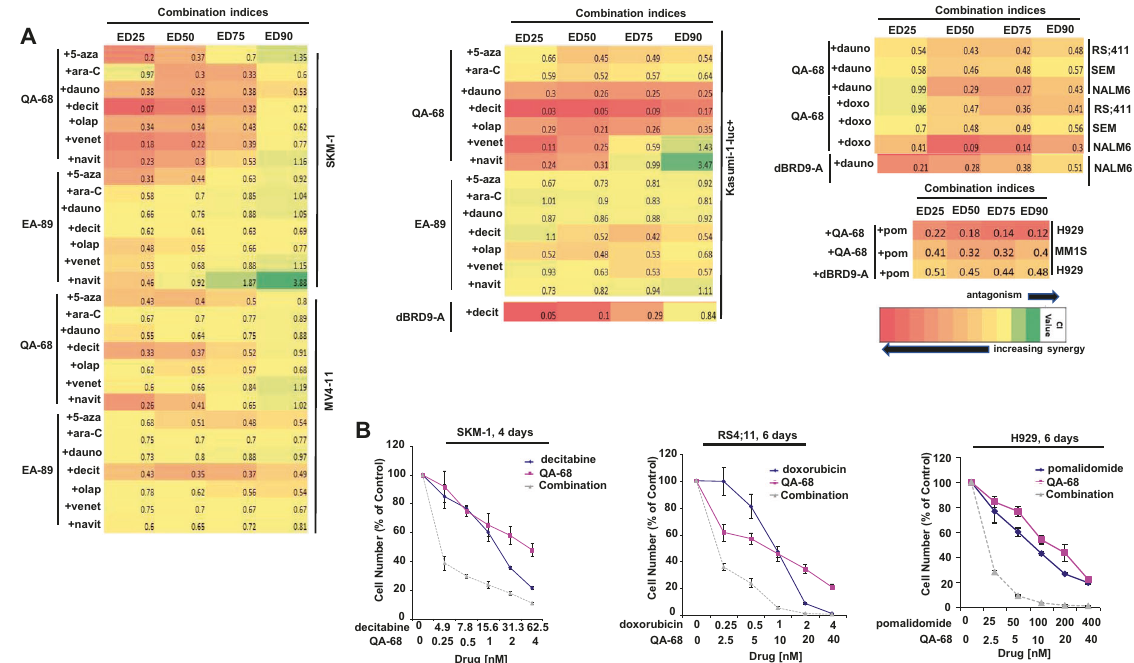
Fig. 7 Targeted inhibition or degradation of BRD9 potentiates the antiproliferative effects of chemotherapy agents and targeted therapies on AML, ALL and MM. A Combination indices generated from combination studies investigating the effects of QA-68 or EA-89 alone or combined with chemotherapy or targeted agents against AML cell lines (left and middle panels) and ALL and MM cell lines (right panel). B Representative dose-response curves showing antiproliferative effects of chemotherapy alone, QA-68 alone, or a combination against SKM-1, RS4;11, and H929 cells. Proliferation studies shown are representative of independent studies performed at least twice for which similar results were observed.